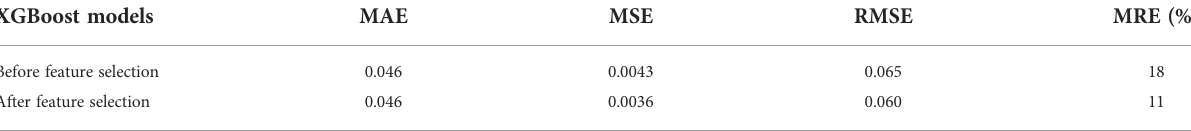
TABLE 3 Comparison of performance of XGBoost models on the validation cohort (N = 135) before and after feature selection. XGBoost models